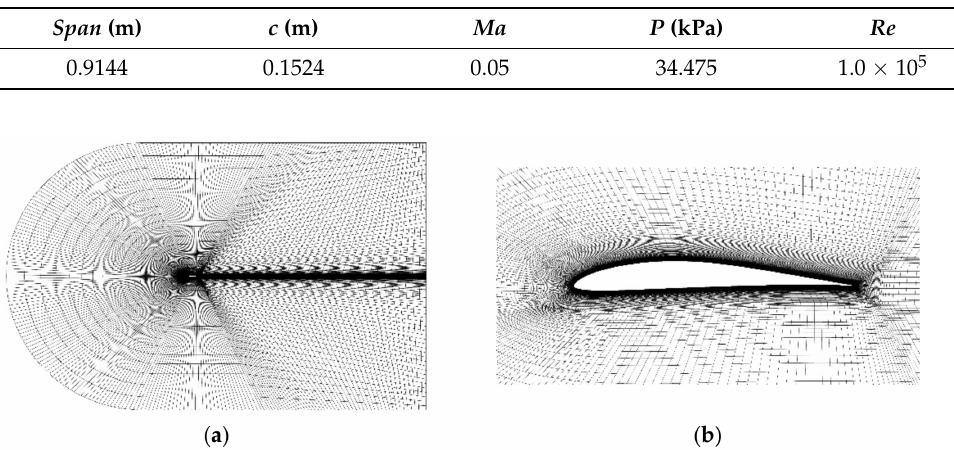
Figure 1. Computation grid of Epller387: ( a ) Computational domain; ( b ) Near-wall grids distribution.